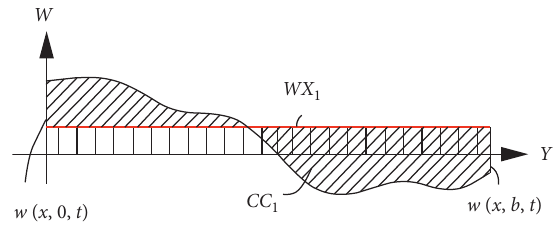
Figure 5: The first interpolation function on the plane ( Y, Z ) .